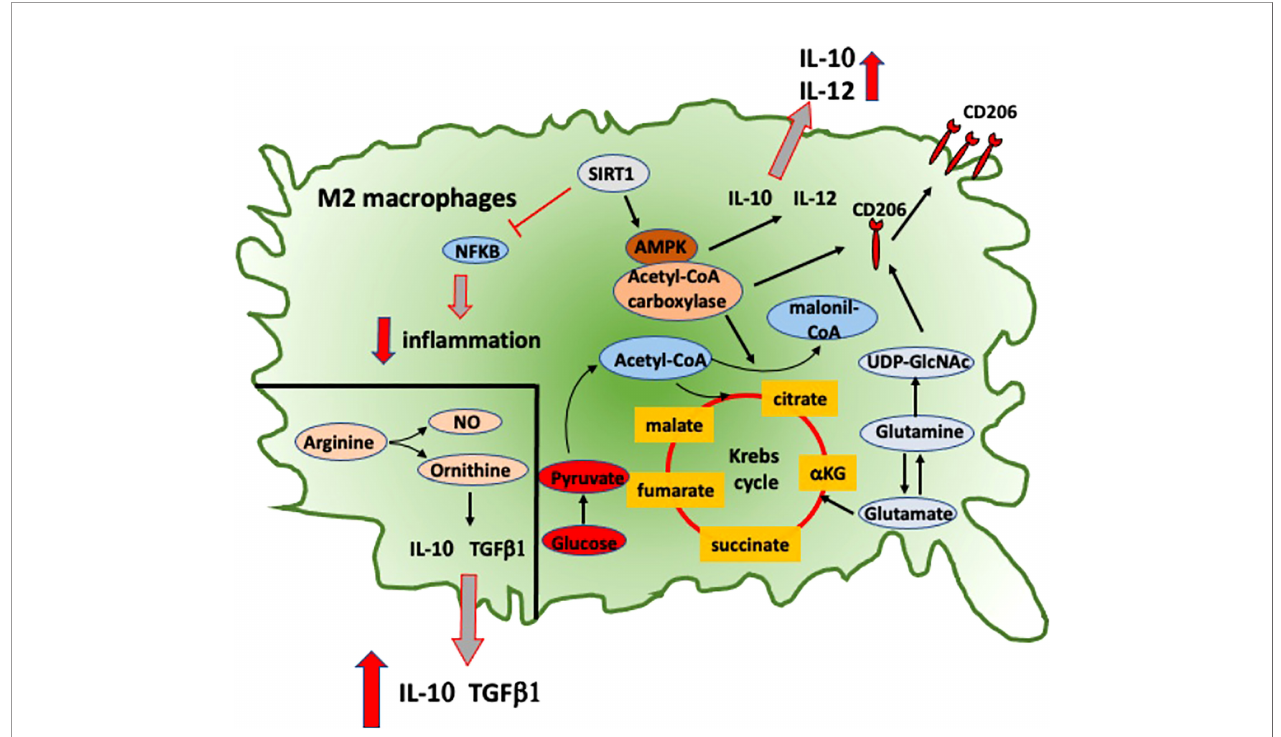
FIGURE 3 | Intracellular signaling and metabolic pathways activated into RA anti-in fl ammatory M2 macrophages. Metabolic pathways activated in M2 macrophages that contribute to their anti-in fl ammatory role in RA. NFkB, nuclear factor-kB; SIRT1, sirtuin-1; AMPK, adenosine monophosphate-activated protein kinase; IL-10, interleukine-10; IL-12, interleukine-12; TGF b 1, transforming growth factor- b 1; NO, nitric oxide; CD206, mannose receptor-1; UDP-GlcNAc, uridine diphosphate